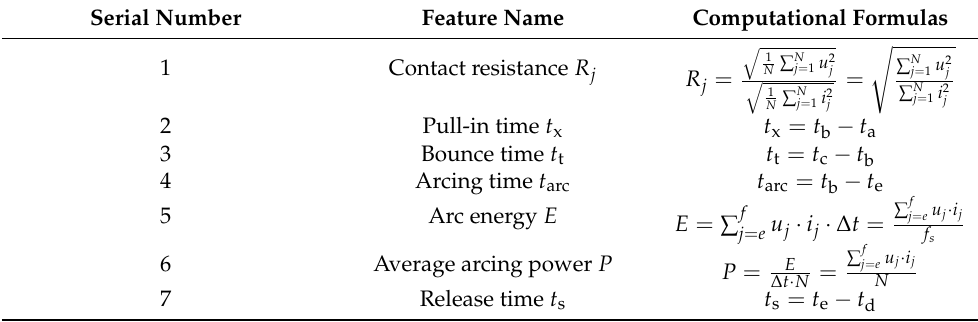
Table 4. Definition of feature